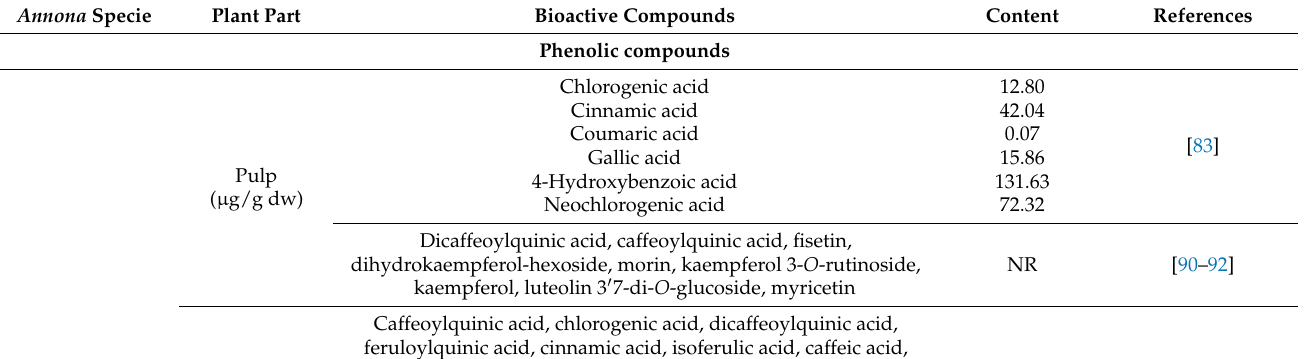
Table 2. Bioactive compounds: phenolic compounds and fatty acids from different plant components of some Annona